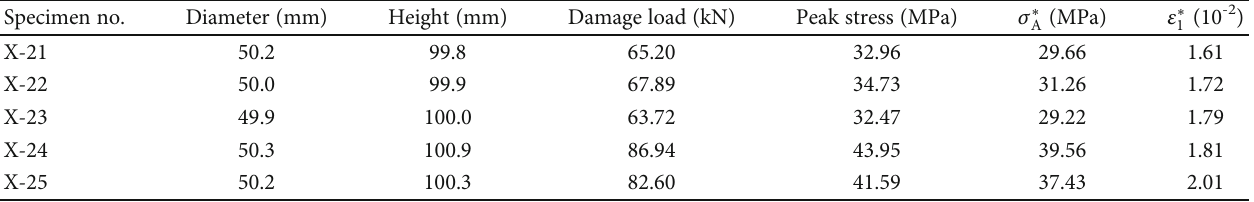
Table 4: The damage load, peak stress, and peak strain of specimens without water under con fi ning pressure of 2 MPa. Specimen